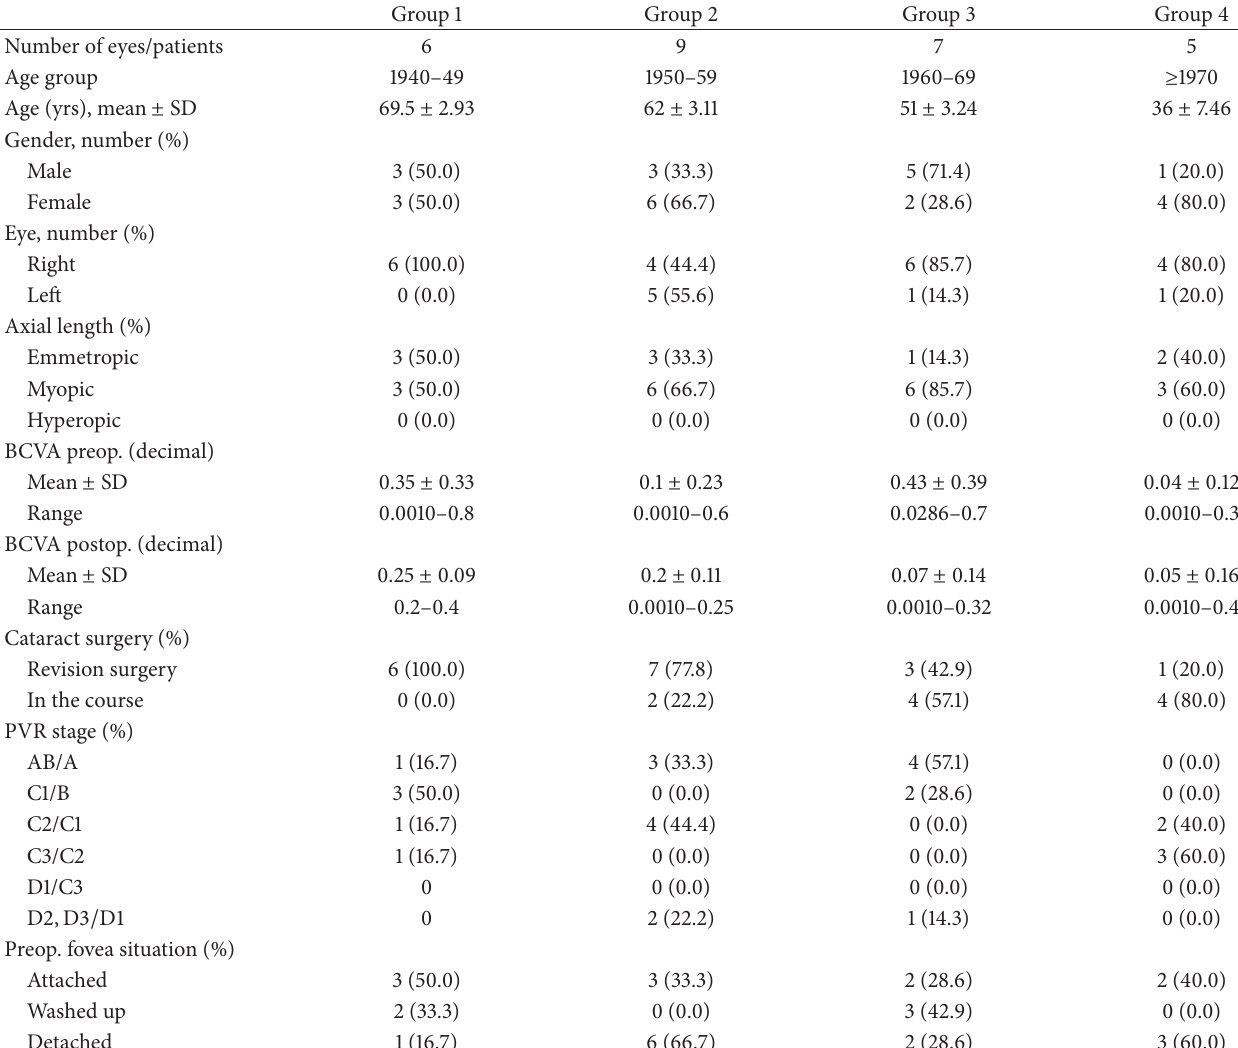
Table 1: Patient’s demographic and baseline characteristics for the subgroup on which Scheimpflug photography was performed and could be analyzed after quality